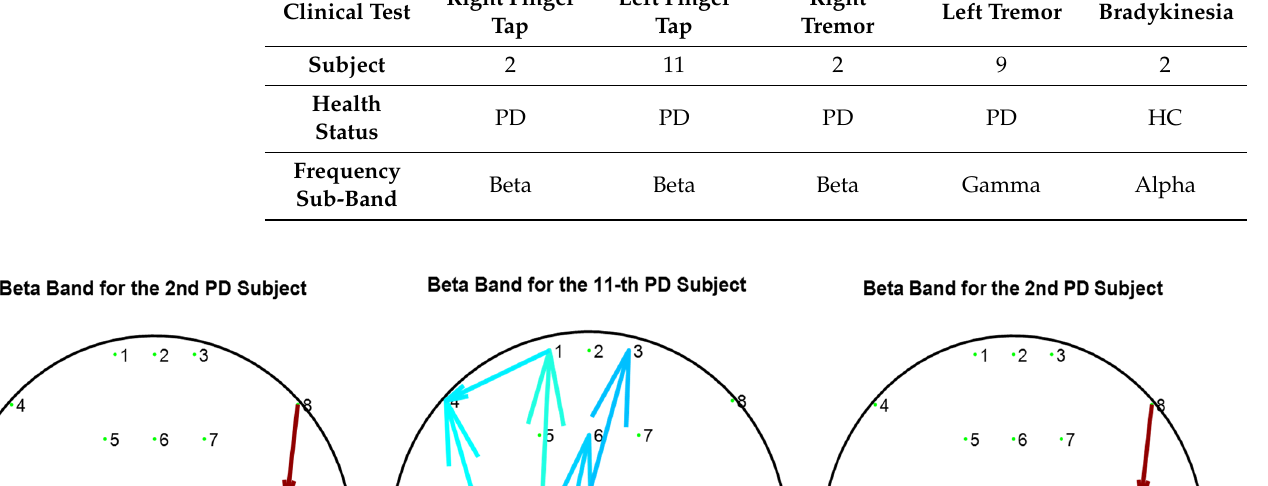
Table 7. A related subject, health status (PD/HC), and the band of the DC heat map leading to the maximum value among 64 features for each clinical test. Figure 5. Correlations and the related p -values for the fitted LASSO models on two latent space and non-latent space cases to regress the clinical scores. Table 6. t-Statistics values between the correlation of latent and non-latent space values with each clinical data sample for the 30 runs.